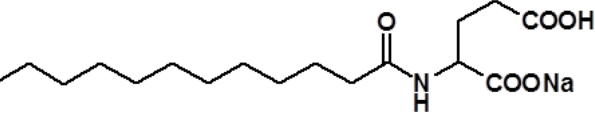
Figure 1. Chemical structure of N -lauroyl- L -glutamate (C12- L